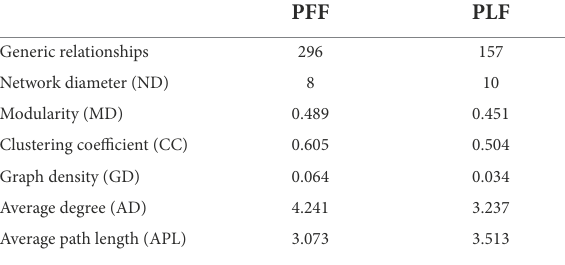
TABLE 2 The networking of gut microbiota in different phase. TABLE 3 The changes of correlation in the network of gut